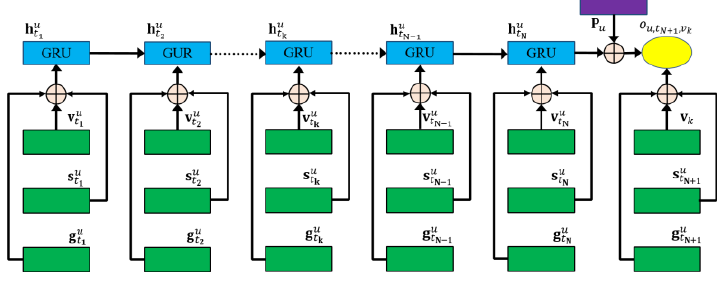
Figure 3. The architecture of ST-GRU network.